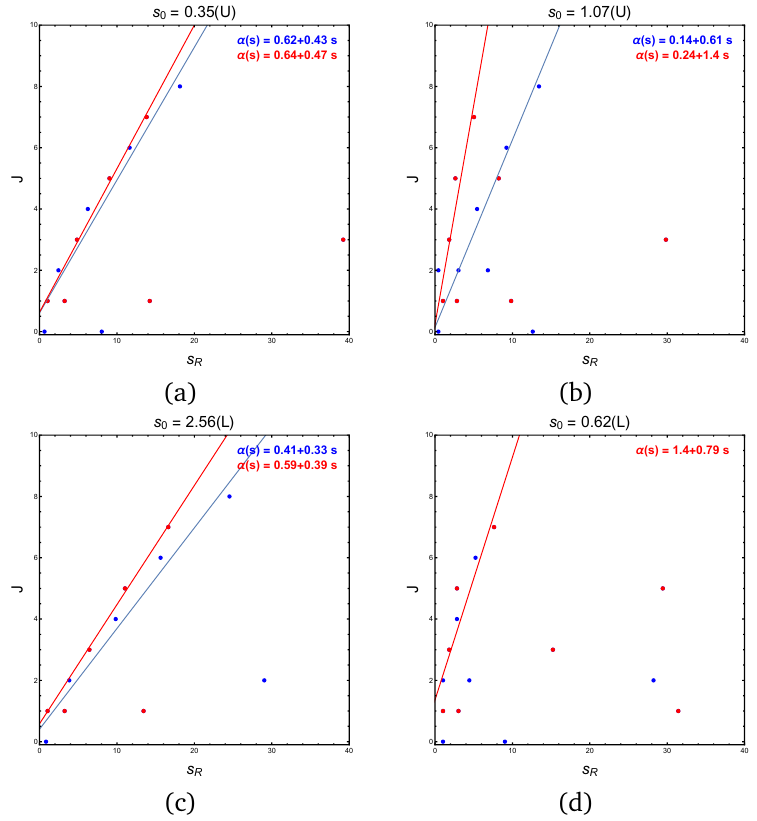
Figure 9: (a) Region A : Red lines give best fit odd trajectories and blue lines describe best fit even trajectories (equations mentioned in the inset). Both even and odd lines are close together. (b) Region B : Even and odd lines somewhat separated (c) Region C : Even and odd lines closer than region B but farther than region A and (d) Region D : (cid:96) = 8 missing. Some daughter resonances can be observed in all